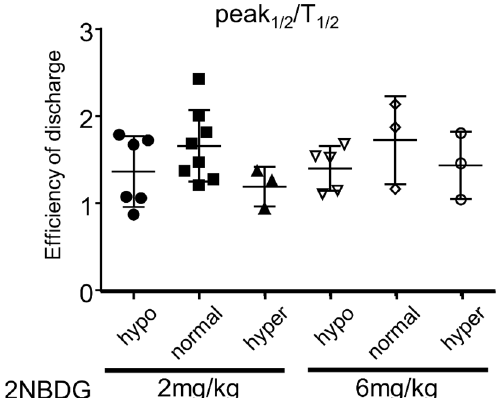
Figure 5. Effects of blood glucose level on 2-NBDG (2 or 6 mg/kg) transport from cytosol to interstitium in early segments of proximal tubules. P1/2/T1/2 was compared between groups. Hypo: hypoglycemia, normal: normoglycemia, hyper: hyperglycemia. Each dot represents an average value from five proximal tubule cells in each mouse ( n = 3–8 for the 2 mg/kg group and n = 3–5 for the 6 mg/kg group).